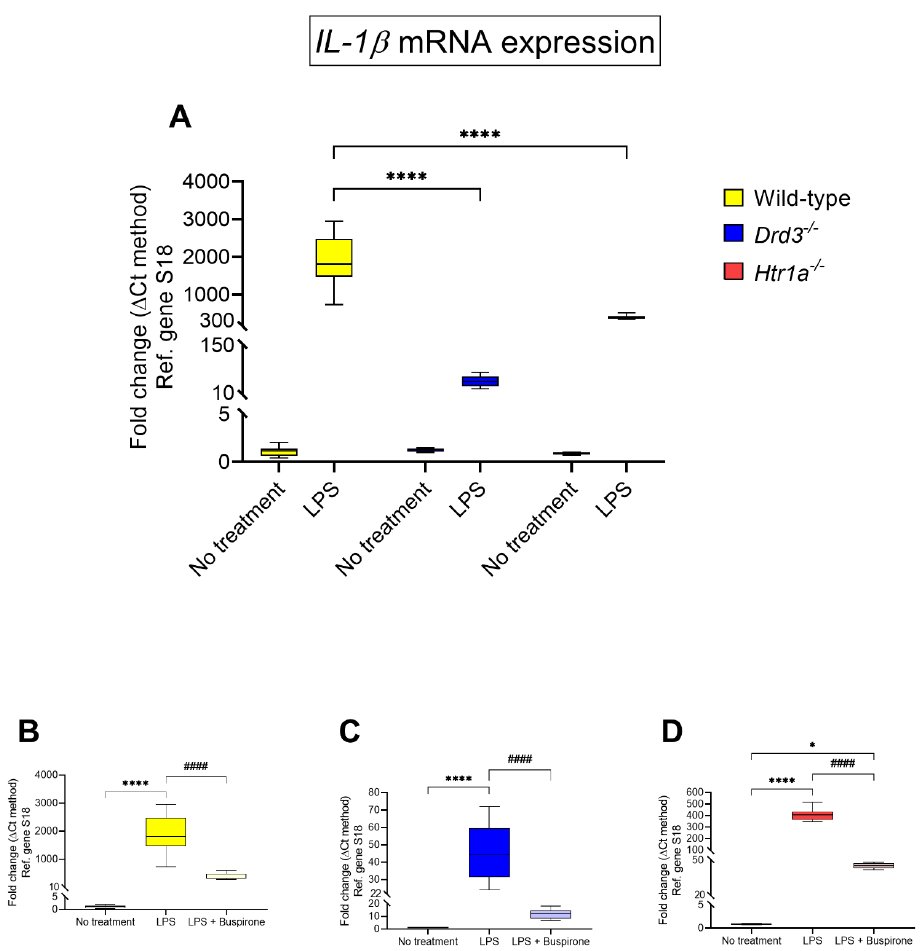
Figure 5. IL-1 β mRNA expression following exposure to LPS and treatment with buspirone for 24 h. Gene expression was measured using real-time qPCR and quantified using the ∆∆ Ct method after normalization to the S18 housekeeping gene. ( A ) Box and whisker plots showing the differential expression of IL-1 β transcripts in untreated or LPS-treated wild type, Drd3 − / − and Htr1a − / − cells or after co-treatment of ( B ) wild type, ( C ) Drd3 − / − and ( D ) Htr1a − / − cells with buspirone. Results are presented as mean fold changes with respect to no treatment (control) ± SEM. Baseline levels of no treatment groups were set to 1. * p < 0.05 or **** p < 0.0001 vs. no treatment or #### p < 0.0001 vs. LPS were determined by one-way or two-way ANOVA followed by Tukey and Dunnett’s post-hoc